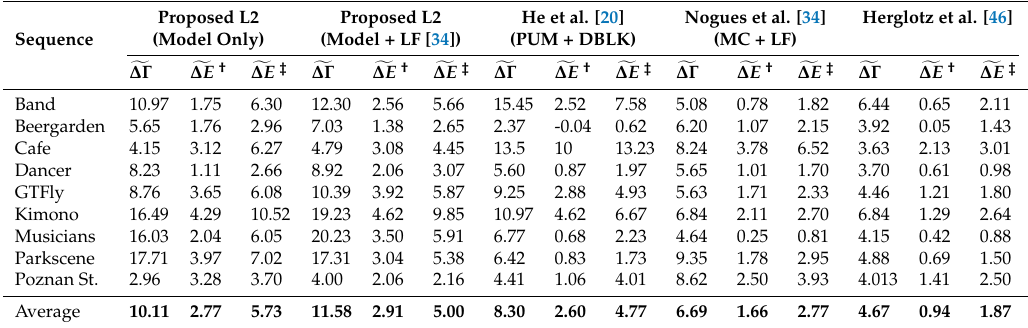
Table 5. Decoding-complexity and energy reduction per 1 dB quality loss for the proposed and state-of-the-art